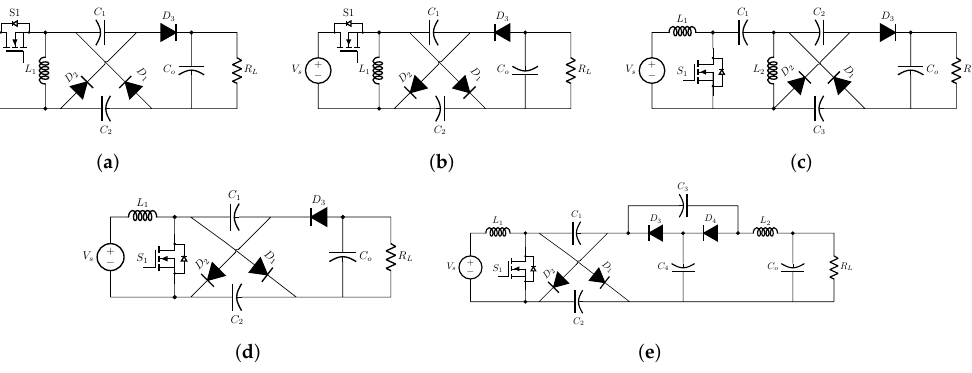
Figure 9. Switched Capacitor (SC) Techniques. ( a ) Zeta Converter based on Non-inverting SC Cell, ( b ) Zeta Converter based on Inverting SC Cell, ( c ) SEPIC Converter based on Non-inverting SC Cell, ( d ) ´Cuk Converter based on Inverting SC Cell and ( e ) ´Cuk Converter with Voltage Doubler based on Inverting SC